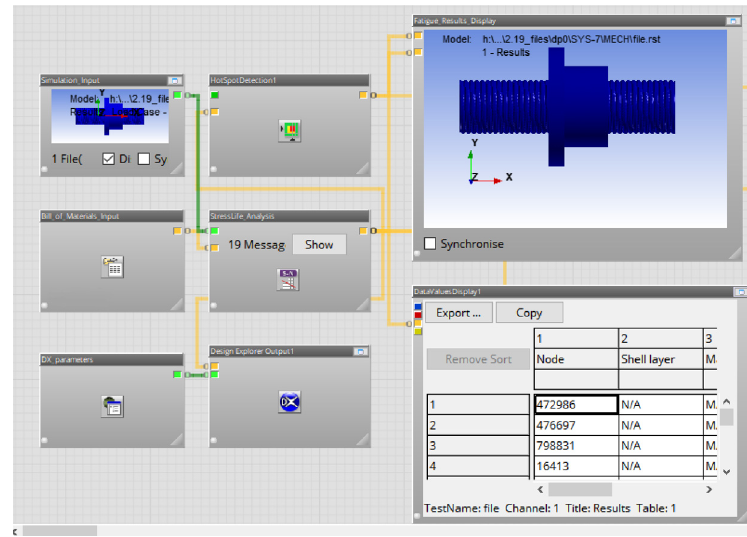
Fig. 12. Fatigue analysis interface of ball